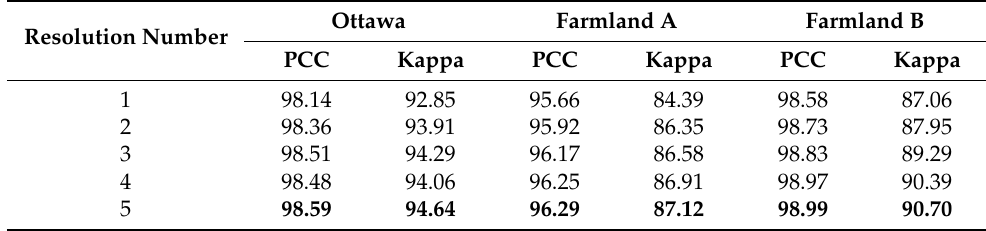
Table 7. Effect of the resolution